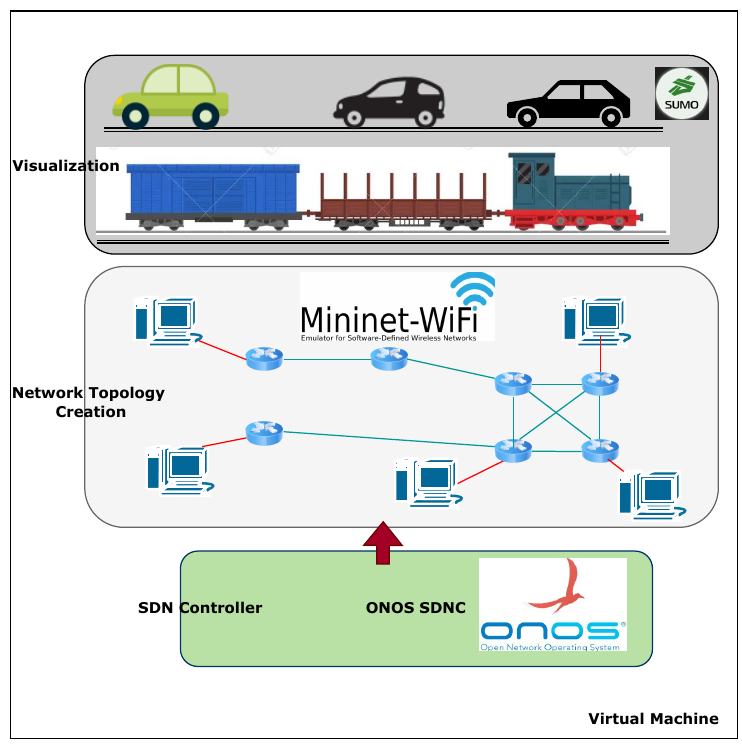
Figure 2. Test setup